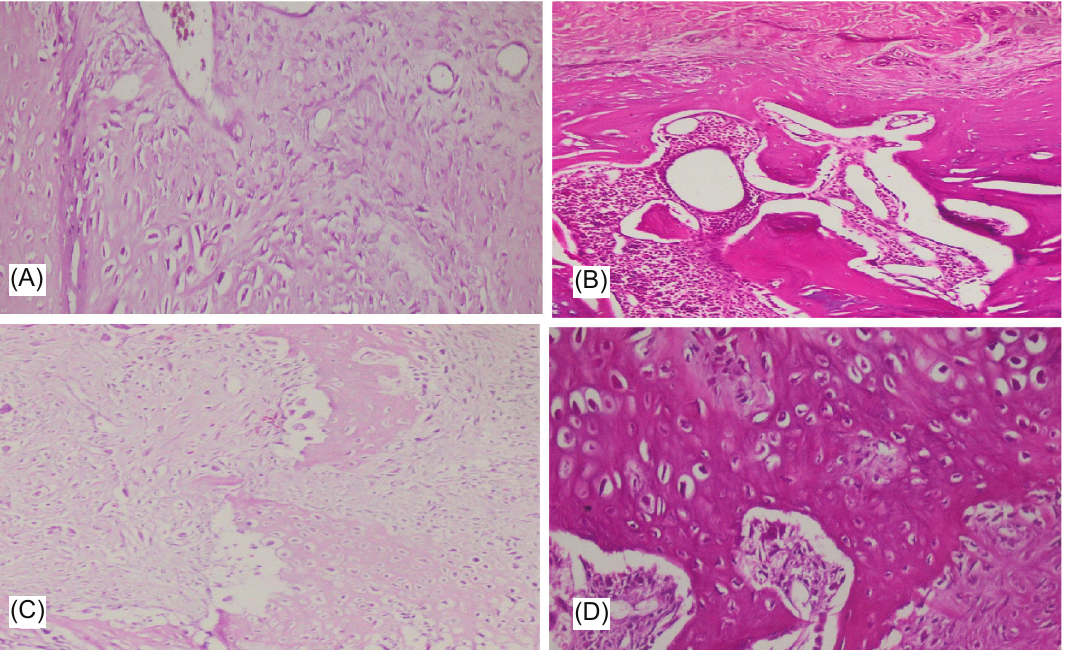
Figure 2. Histological progression of fracture healing. A : Predominant cartilage tissue with less fibrous tissue (Grade 3) in a fractured femur from Group A on the 15th day. B : Immature bone tissue with cartilage tissue in a uniform manner (Grade 7) in a fractured femur from Group B on the 30th day. C : Wide area of fibrous tissue with less cartilage tissue (Grade 2) in a fractured femur from Group C on the 15th day. D : Wide area of cartilage tissue (Grade 5) in a fractured femur from Group D on the 30th day.